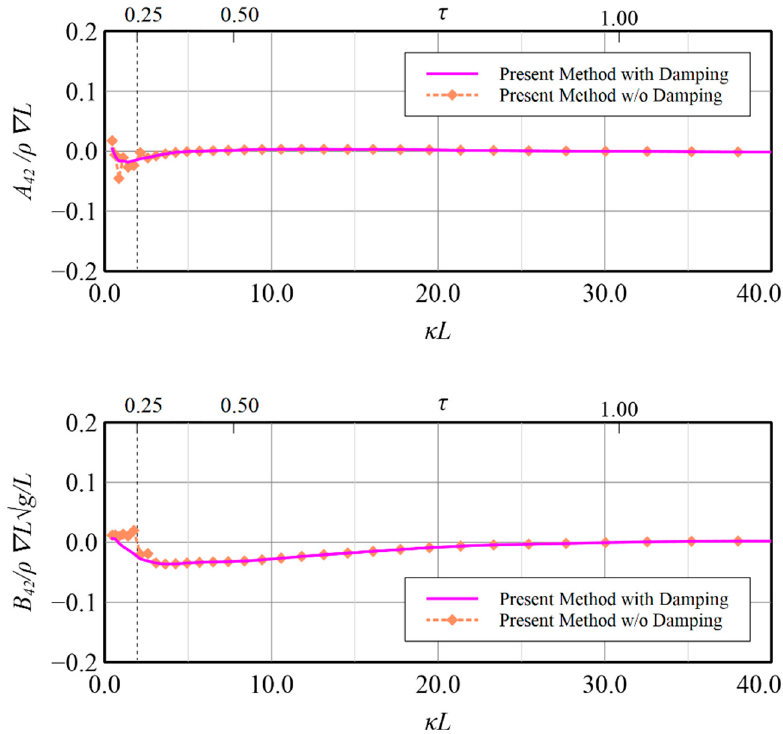
Figure 25. Sway-induced-roll added mass and damping coefficient at F r = 0.18.